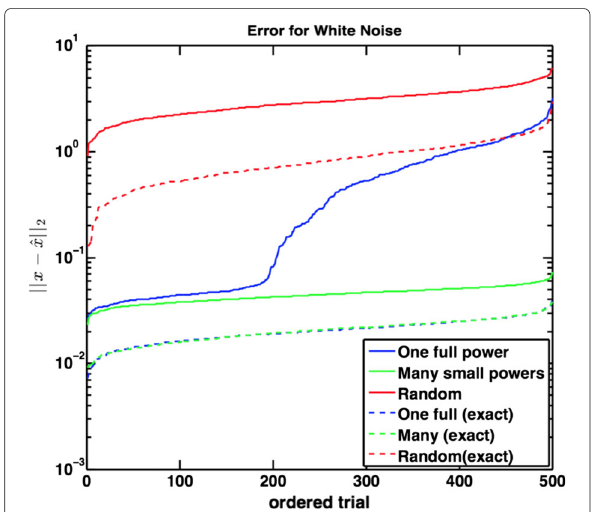
Fig. 4 Comparison of sensing a Gaussian signal with dimension n = 100 using unit power measurements along the eigenvector direction, versus splitting each unit power measurement into five √ 1 / 5, and we update the smaller ones, each with amplitude covariance matrix in between. The mismatched covariance matrix is (cid:2) (cid:2) ∝ (cid:2) + rr (cid:2) , where r ∈ R n × 5 and each entry of r is i.i.d. N ( 0,1 ) , and (cid:2) (cid:2) is normalized to have unit spectral norm. Performance of the algorithm in the presence of mismatch is compared with that with exact